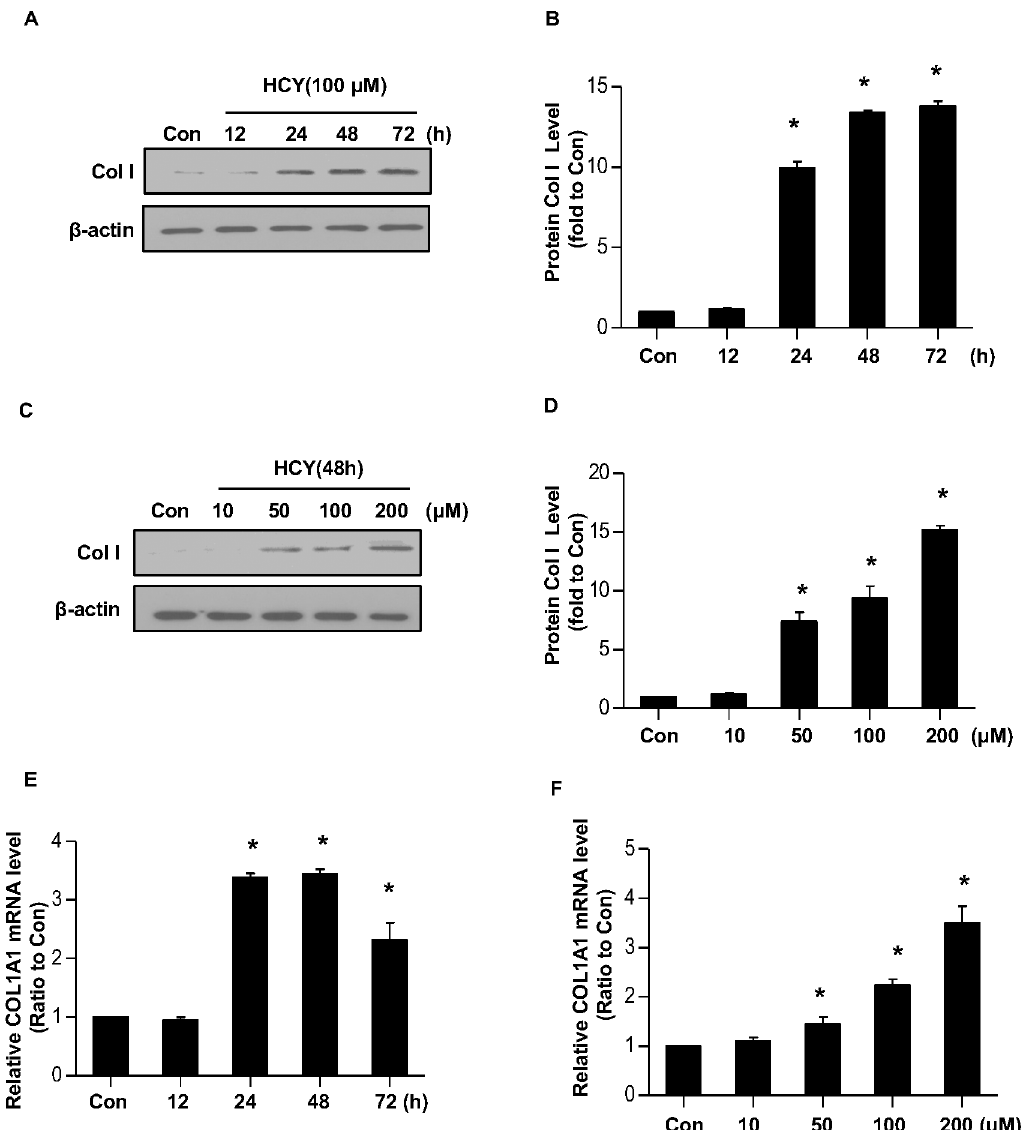
Fig 1. Hcy induces Col I expression in LO2 cells. LO2 cells were incubated with 100 μ M of Hcy for indicated time period, or indicated concentration of Hcy for 48 h. The protein level of Col I was determined by Western blotting (A-D). β -actin was used to verify equivalent loading. Graphic representation of relative protein level of Col I normalized to β -actin (B, D). The mRNA level of COL1A1 gene was determined by real time PCR (E-F). Data are mean ± SD of three independent experiments. * p < 0.05 versus control